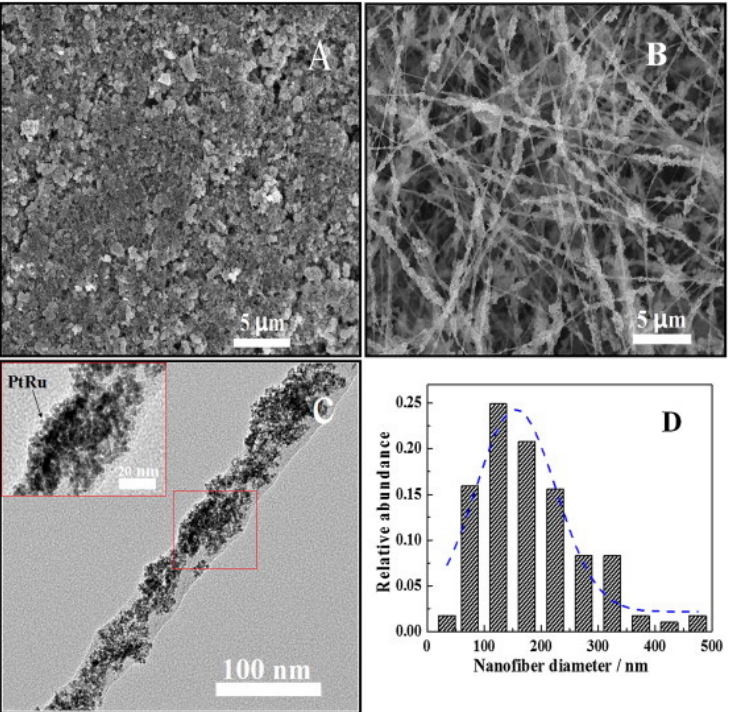
Figure 8. Scanning electron microscopy images of ( A ) a conventional gas diffusion electrode; ( B ) an electrospun gas diffusion electrode; ( C ) transmission electron microscope image of electrospun PtRu-C/Nafion/PVA nanofiber; ( D ) diameter distribution of the electrospun nanofiber mat. Reprinted from [219], with permission from Elsevier.